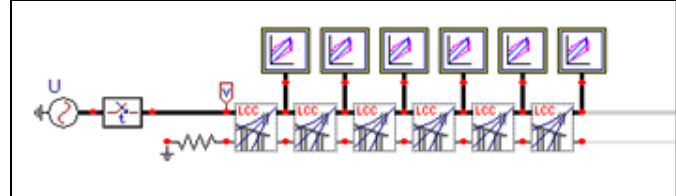
Figura 2. Equivalente Circuital empleado en la representación del efecto